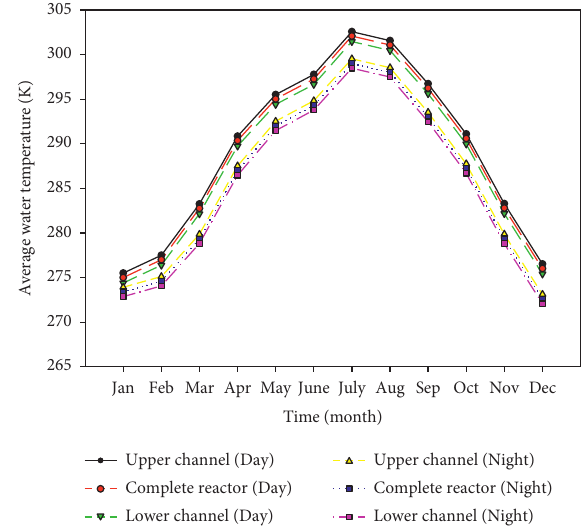
Figure 3: Average water temperature for reactor inclined at 1 ° , Re � 9000, AR � 180, and water depth of